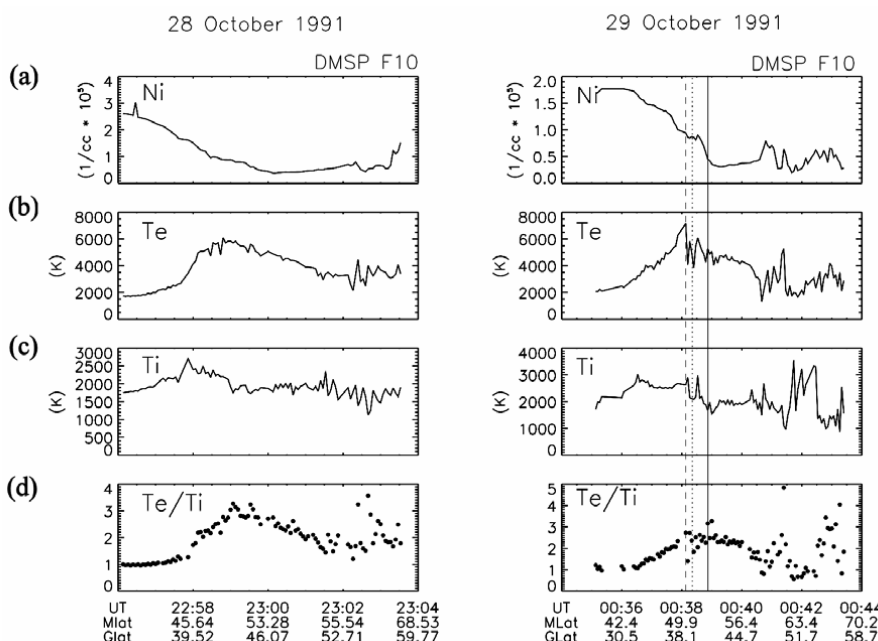
Fig. 10. DMSP plasma parameters for the portions of the over-flight passes shown in Fig. 9. (a) plasma density, (b) electron temperature, (c) ion temperature, (d) T e / T i ratio, all versus latitude (magnetic and geographic) and time (UT) on 28–29 October 1991. For the pass on the 29th, three times are marked to show the relationship between the DMSP data vs. latitude (dashed line 00:38:08 UT), the ISR off-zenith data (dotted line at 00:38:21 UT), and the 6300 ˚A image (solid line at 00:38:52 UT). See text and Fig. 11.